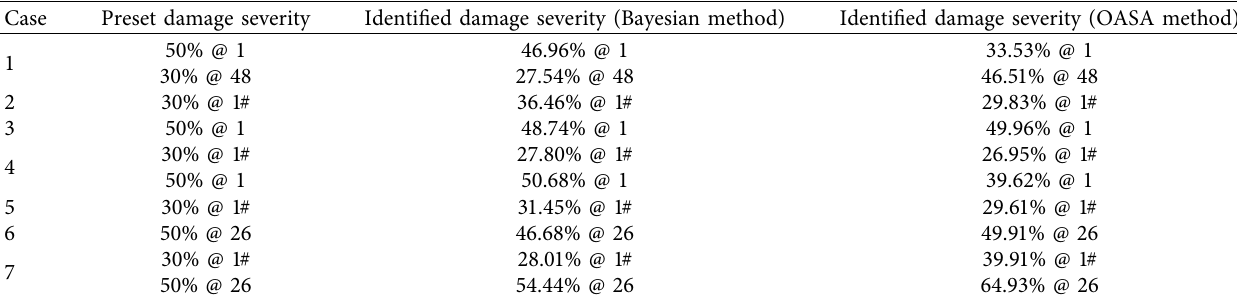
Figure 14: The Markov chains and histograms of damage case 7. Table 2: The damage identification results of the continuous beam